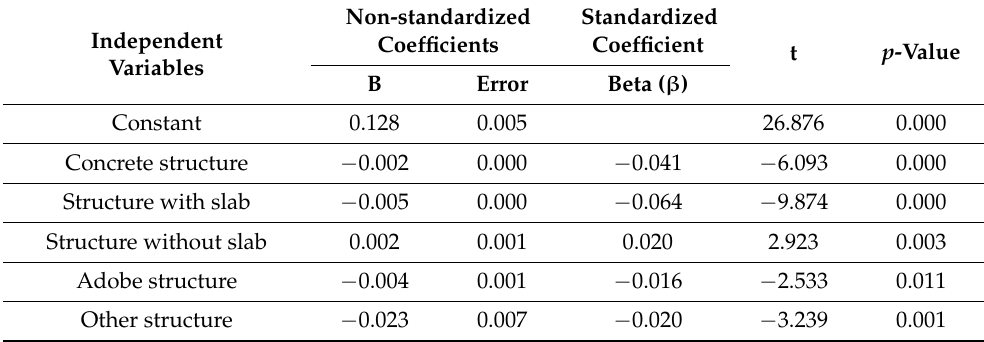
Table 3. Summary of multiple regression significance of building materials explanatory variables.